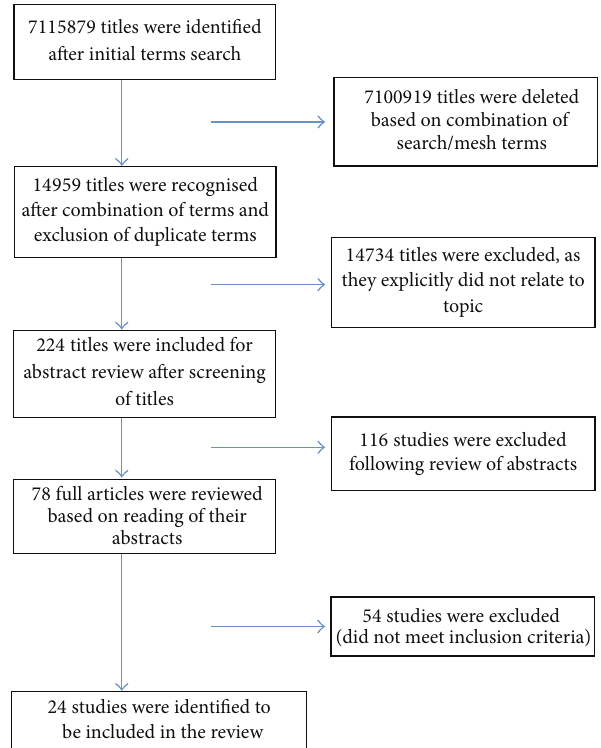
Figure 1: PRISMA diagram for the selection of studies included in the